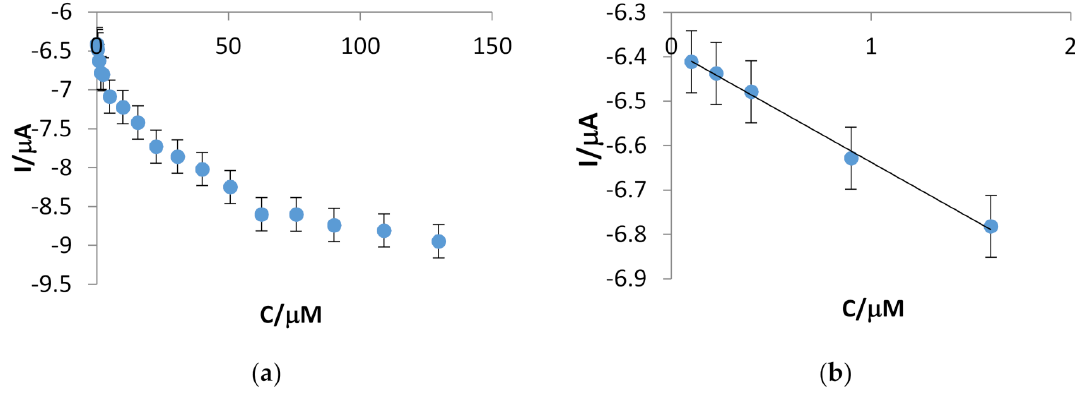
Figure 5. The calibration curve of the biosensor in the concentration ranges 0.1–129.6 µ M ( a ) and 0.1–1.6 µ M ( b